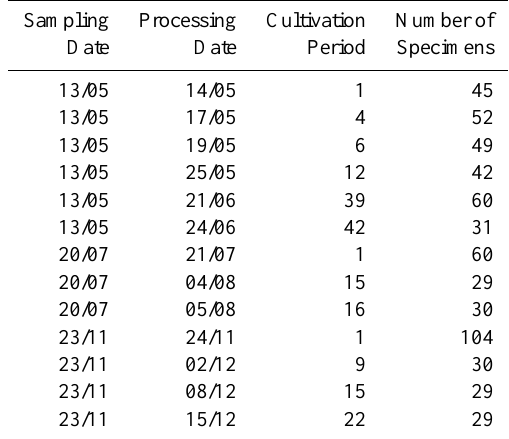
Table 1. Dates of sampling and sample processing in 2010, cultiva- tion periods (days), and number of specimens of A. tepida picked from each sample at different cultivation